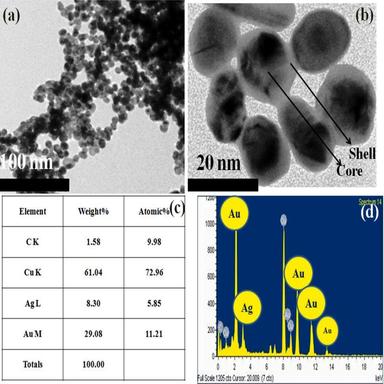
TEM images (a–b), atomic % (c) and EDAX (d) of Au/Ag-NPs.